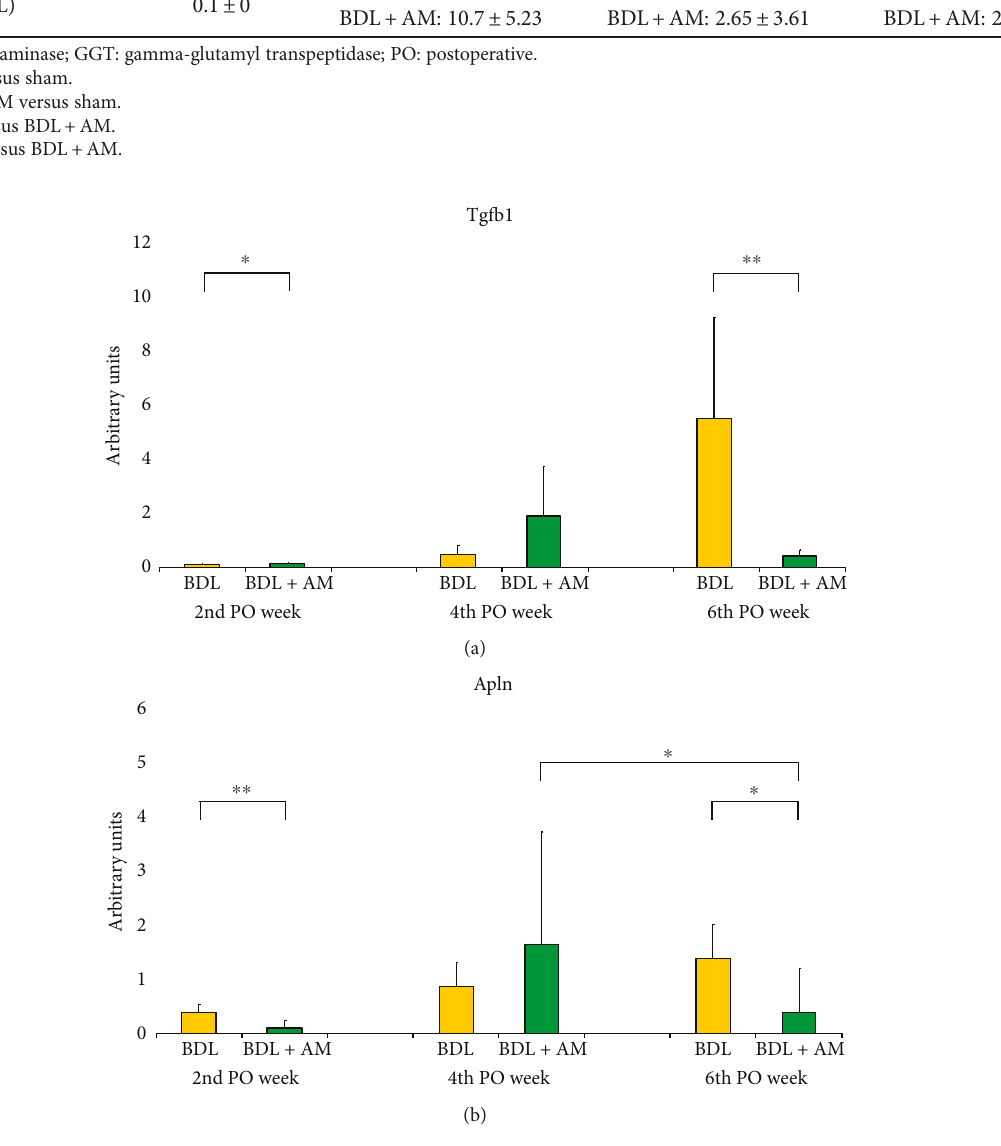
Figure 4: mRNA expression levels of pro fi brogenic genes in arbitrary units as “ fold change. ” (a) mRNA expression levels of Tgfb1 . In the BDL group, Tgfb1 exponentially increased along the experiment. Marked di ff erences were noted on the 6th postoperative week between the BDL group and the BDL+ AM group. (b) mRNA expression levels of Apln . In the BDL group, Apln increased in a linear way over time. Marked di ff erences were also noticed on the 6th postoperative week between the BDL group and the BDL+ AM group. Additionally, a reduction in expression levels of Apln was noticed in the BDL+AM group among the 4th and 6th postoperative weeks. SS: sham surgery; BDL: bile duct ligature; BDL+AM: bile duct ligature plus amniotic membrane; PO: postoperative. ∗ p < 0 05 BDL versus BDL+ AM; ∗∗ p < 0 01 BDL versus